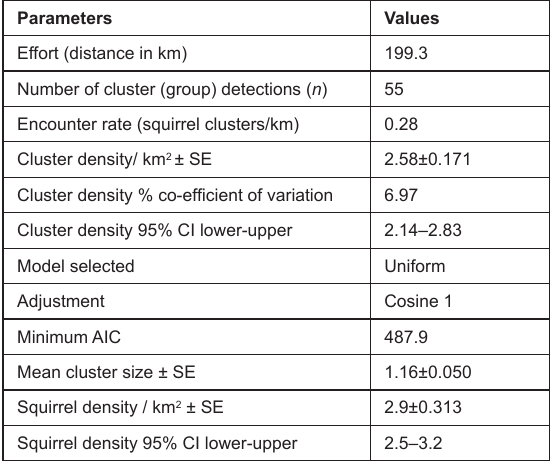
Table 1. Density of Indian Giant Squirrel estimated in Mudumalai Wildlife Sanctuary using line transect method and DISTANCE software